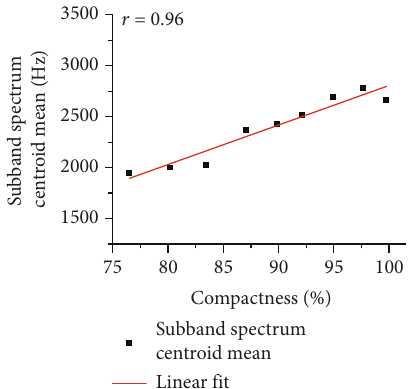
Figure 17: Correlation diagram of the mean value of the centroid of the subband spectrum and the soil mass with di ff erent compaction degrees under the action of 55(L) N hammering force.